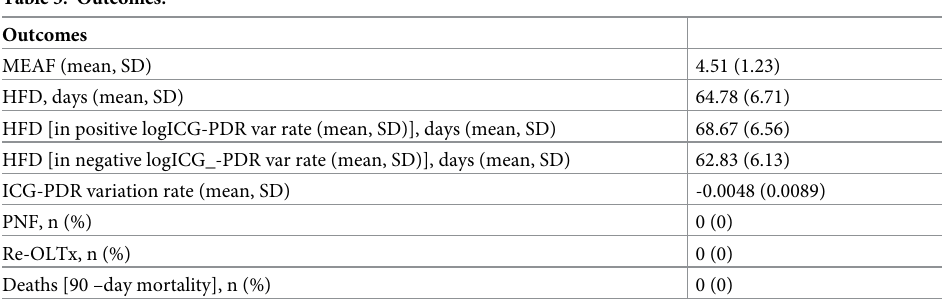
Table 3. Outcomes.